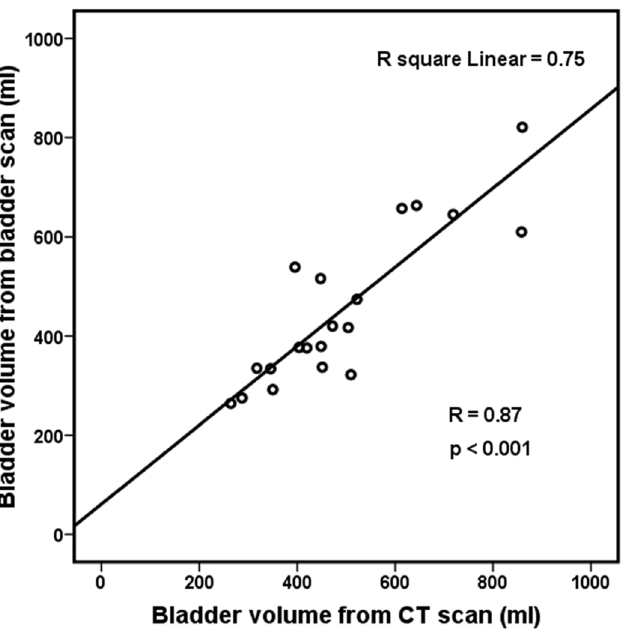
Fig 1. Correlation of bladder volume measured using a bladder scan and simulation CT scan. This figure depicts that bladder volumes measured by bladder scan highly correlated with those on simulation CT scan (R = 0.87, p <